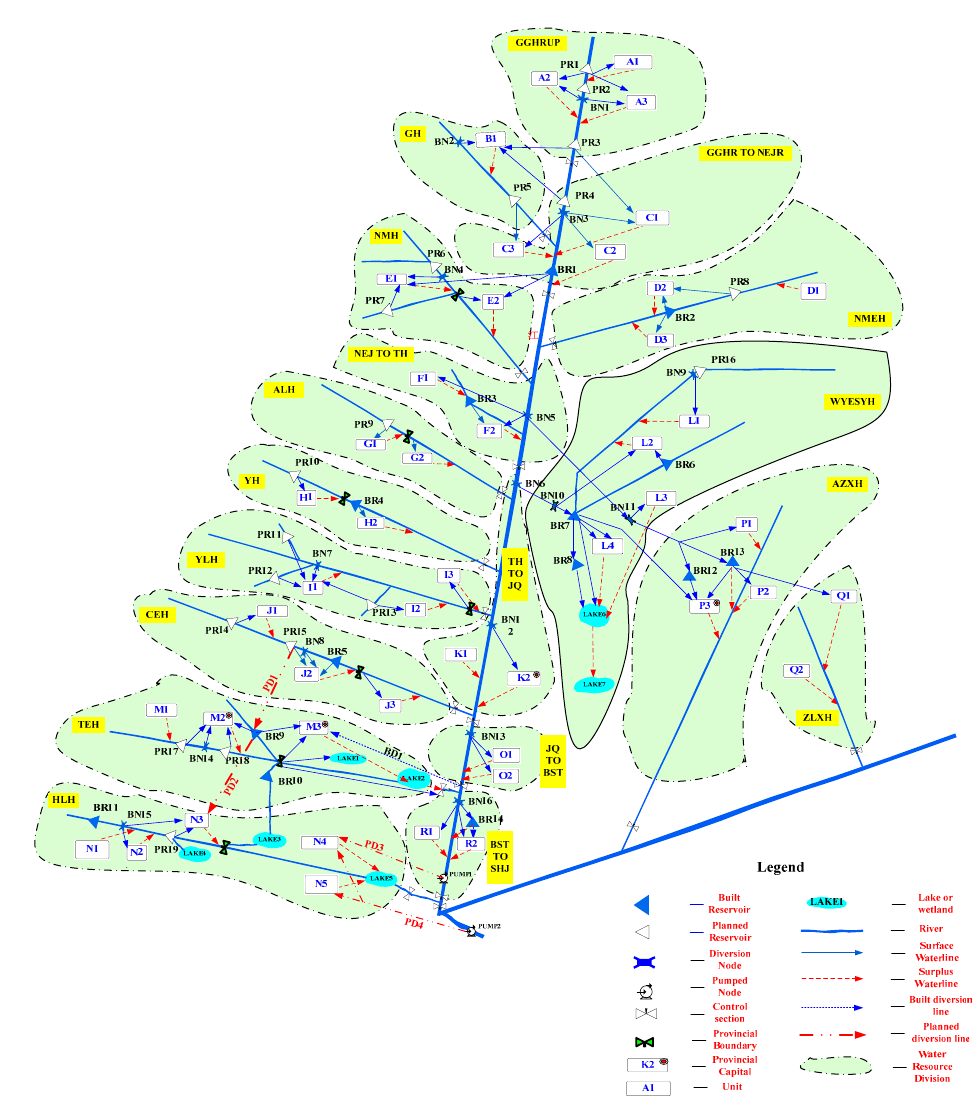
Figure A1. Water resources allocation network chart of Nen River basin.